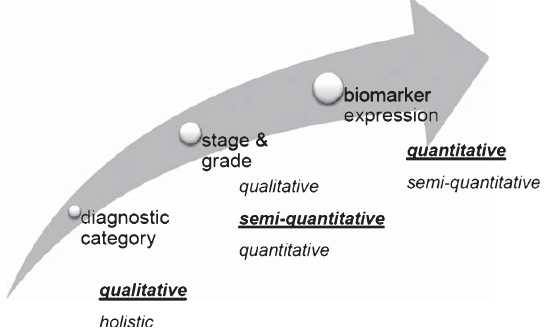
Fig. 1. Evolutionary change in pathology: increasing demand for